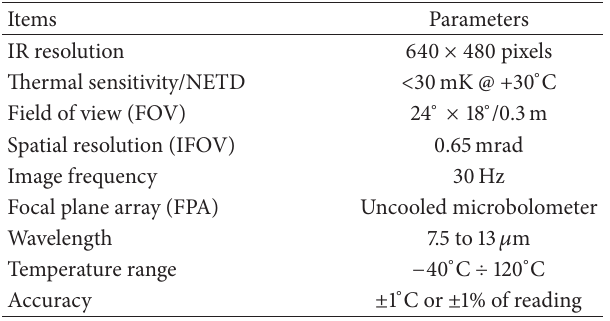
Table 3. The camera automatically calculates the atmospheric transmission based on distance and relative humidity. It also provides tools to adjust the emissivity of the material and to measure temperature at any region of interest (ROI) types, such as spots, lines, and circular, rectangular, or polygonal areas. The initial parameters that were used to set up the camera are summarized in Table 4.